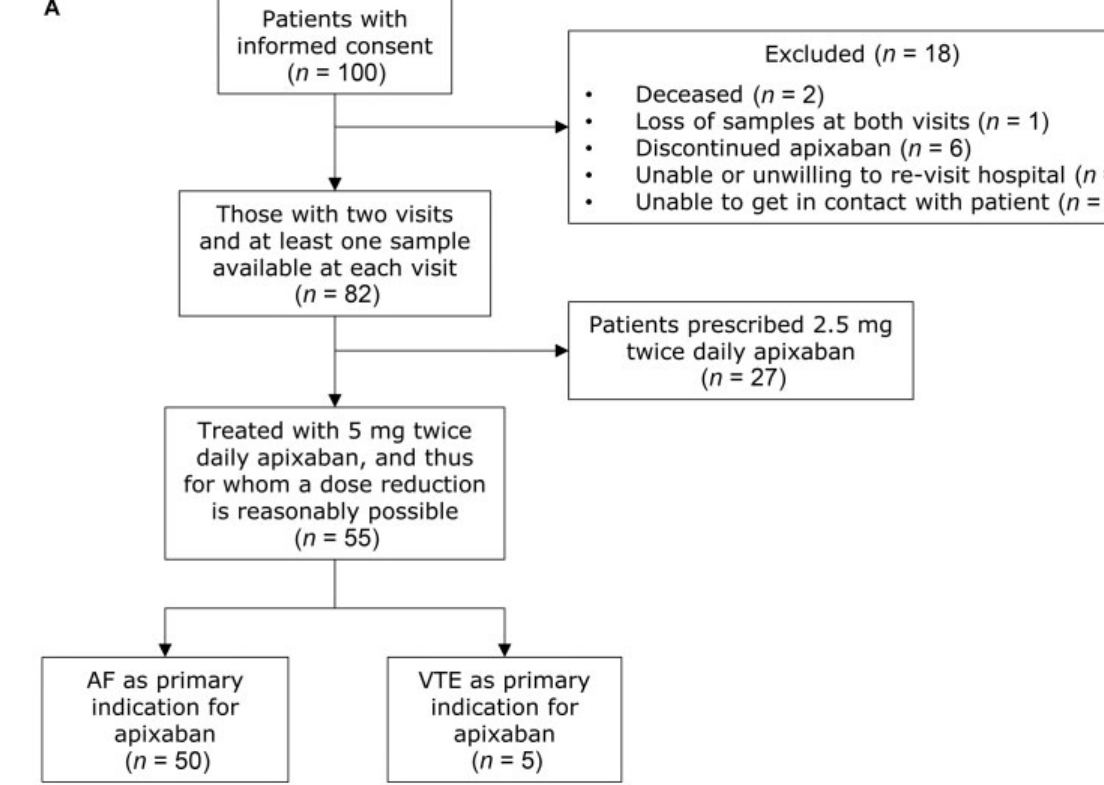
Fig.1 Patient selection: this fi gure summarizes the follow-up of recruited patients, and the reasons for exclusion from the fi nal dataset. AF, atrial fi brillation; VTE, venous thromboembolism. TH Open Vol. 6 No. 1/2022 © 2022. The